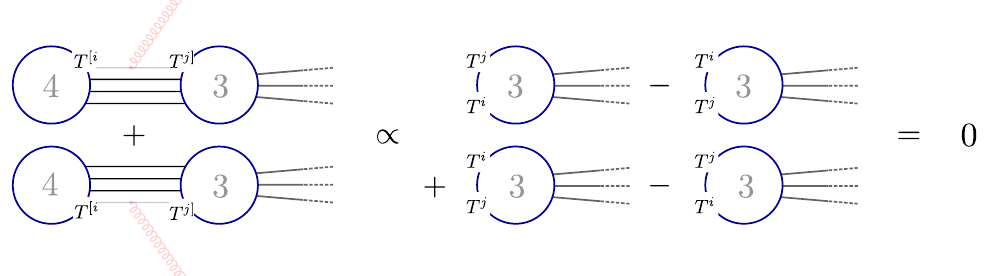
Figure 11 . We sketch the cancellation of the leading large- N term for diagrams of type ( iii ). We start on the top left diagram, which corresponds to part of the (cid:12)rst graph in panel ( iii ) of (cid:12)gure 10. Looking at operator 4, we have a number of matter lines to which colour generators are attached; to the (cid:12)rst of those lines, a YM line is attached. The vertex carries a commutator of the colour generators. Below, we have a similar structure, with the exception that the YM line is now attached to the bottom matter line; this corresponds to the second diagram in panel ( iii ) of (cid:12)gure 10. By using the colour-trace identities of appendix C, we can eliminate the trace corresponding to operator four. We are left with four contributions that cancel each